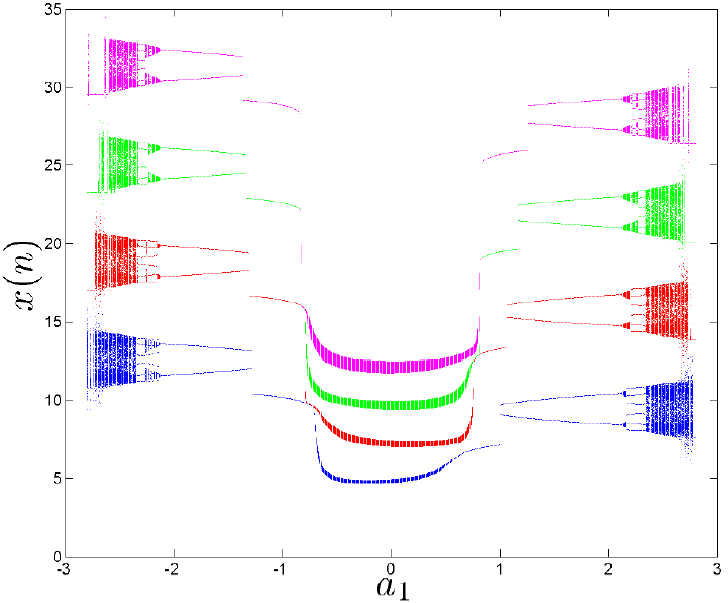
Figure 6. Offset boosting of the map (12) when changing initial condition y ( 0 ) for x ( 0 ) = 1 and α = 0.99 ( a 1 in [ − 2.8,2.8 ] and a 2 = 1.1, a 3 =